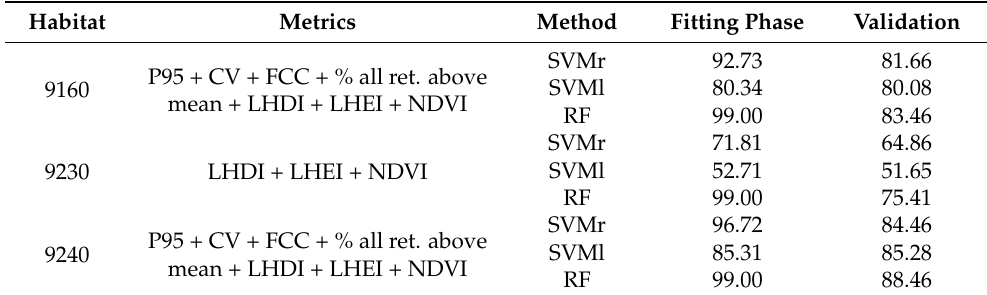
Table 6. Comparison between classification methods using LiDAR and Sentinel metrics. The results refer to the overall accuracy of the three habitats. Additionally, 9160 is Quercus robur habitat, 9230 is Quercus pyrenaica habitat, and 9240 is Quercus faginea habitat.